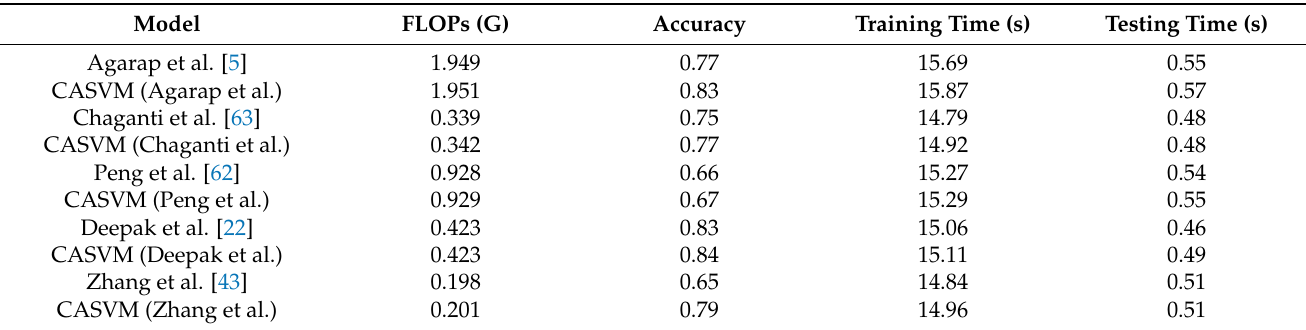
Table 8. Experiments with different